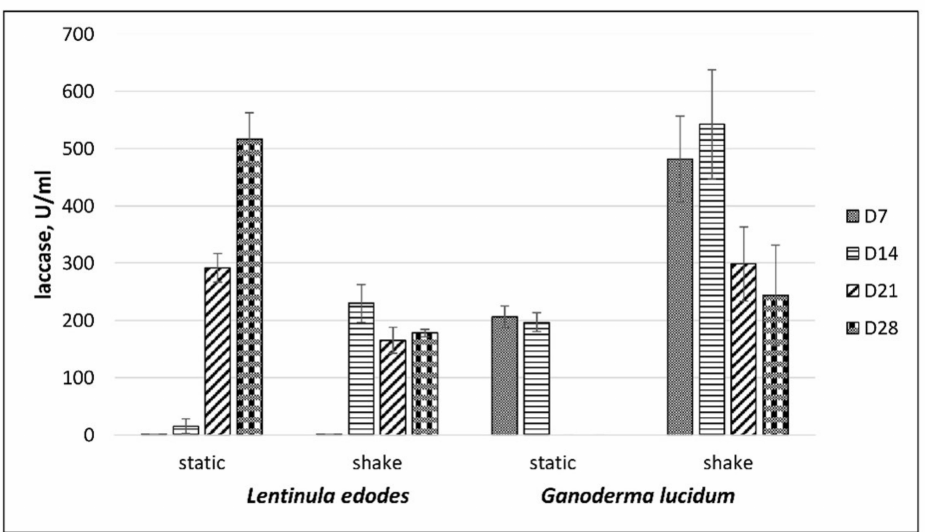
Figure 5. Laccase activity of L. edodes and G. lucidum depending on CS lignin addition in media under shaken and static conditions. D7 and D28—period of incubation